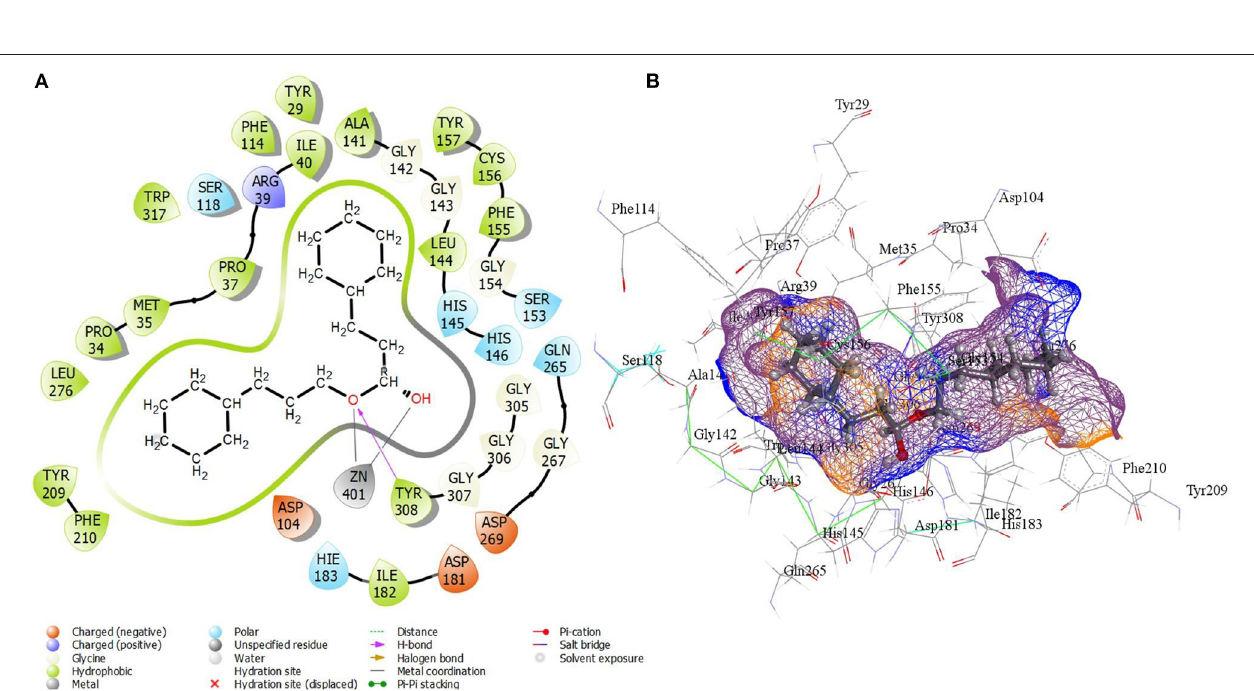
FIGURE 2 | (A) 2D molecular interactions and (B) 3D interactions in the active site of best-docked compound, cinnamyl dihydrocinnamate (CMNPD5348) with HDAC 2 protein after QPLD docking.